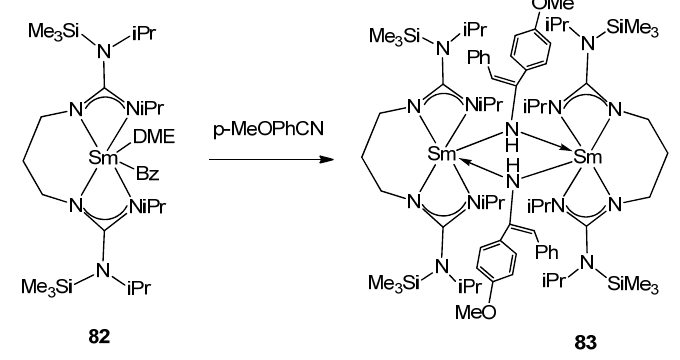
Figure 49. Nitrile insertion in alkyl samarium complex.